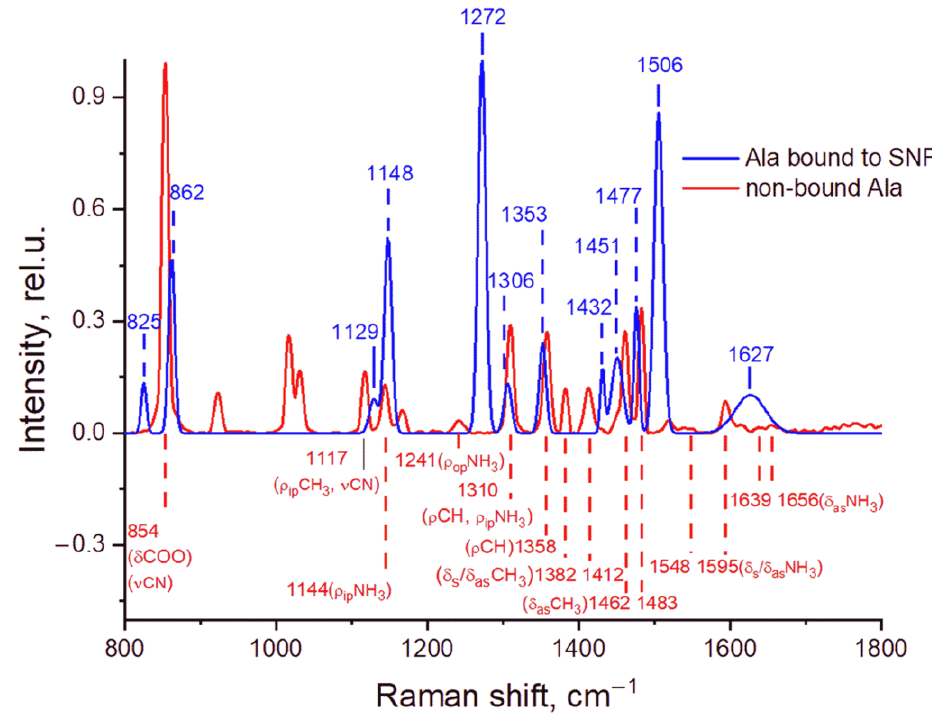
Figure 2. Comparison of Raman spectra of Ala bound to SNF (blue) and non-bound (crystallite) Ala (red). The peaks of crystallite spectrum are assigned to vibration modes of C − N, NH 3 , and CH 3 units: ν -stretching, δ -scissoring, ρ -rocking (ip—in plane, op—out of plane) [26]. The presented refined spectra were obtained by fitting the Gaussian peaks to the respective averaged spectra.